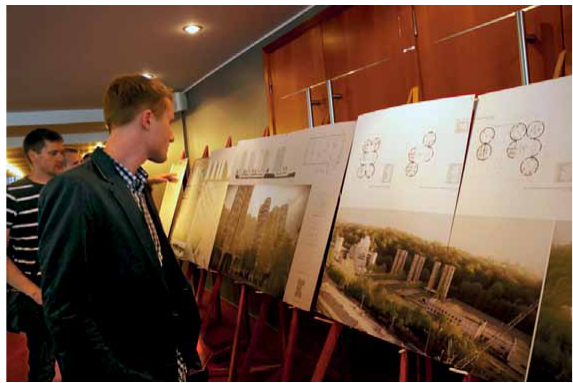
fig. 7. The exposition of the final bachelor degree project in